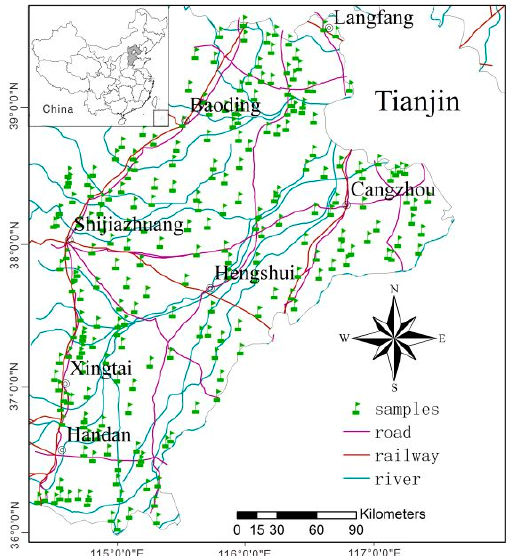
Figure 1. Map of the sampling sites.